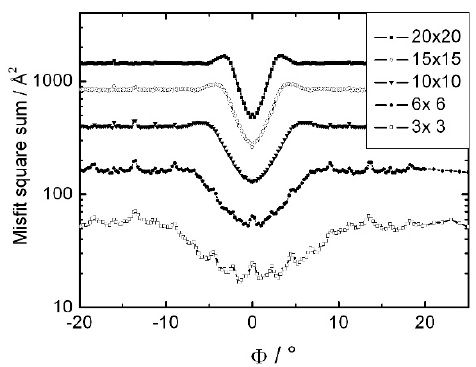
Figure 3. Lattice square misfit sums calculations of the quinquephenyl (201)5P lattice on the Cu(110)(2×1)O lattice for different rotation angles Φ . The extension of the quinquephenyl lattice varied from nine unit cells (3 × 3) to 400 (20 × 20).